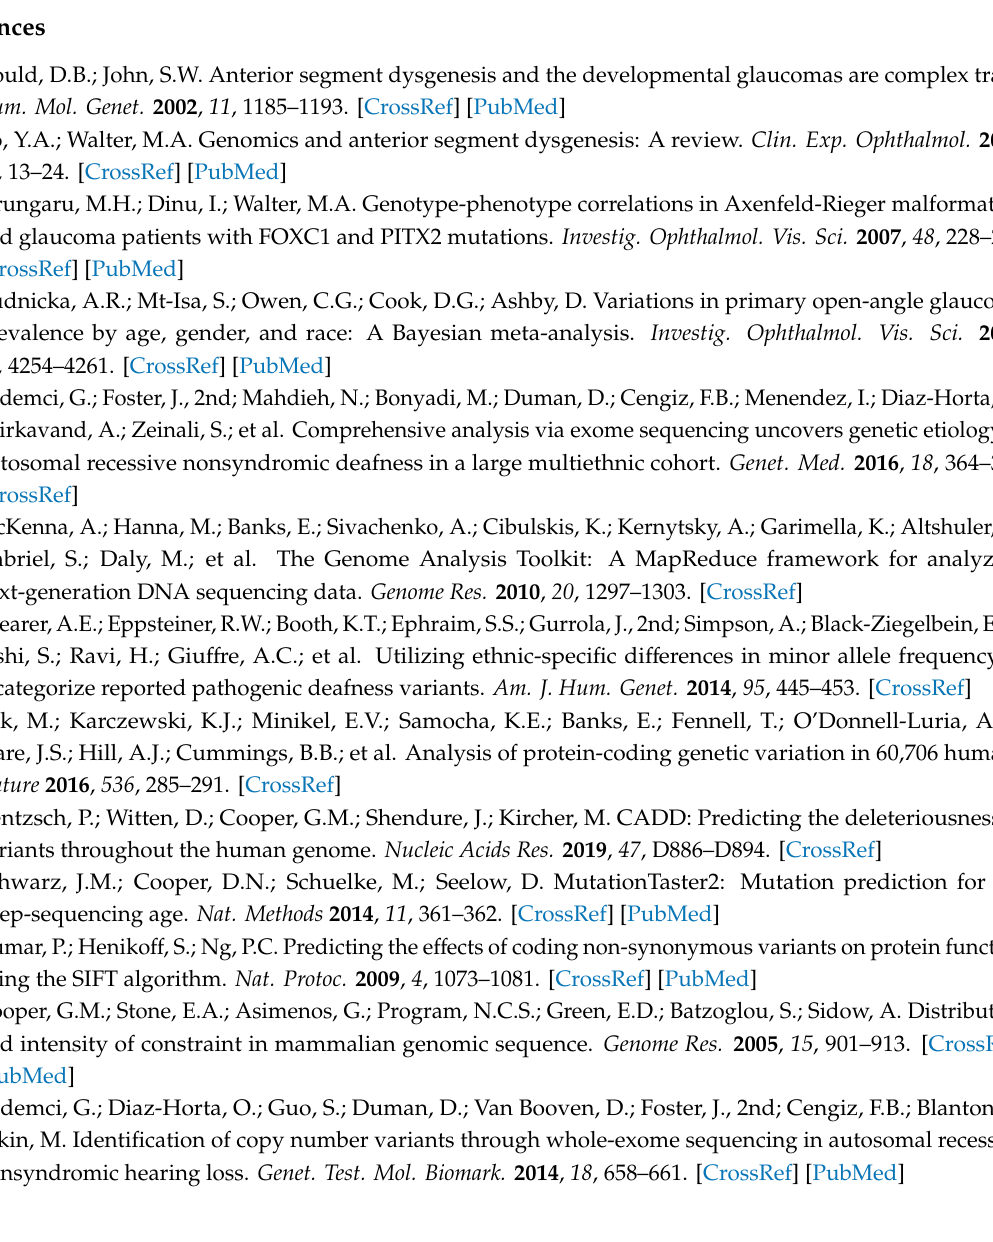
Table S1: List of the genes used for the filtering by using ES in our cohort. Table S2: Syndromic and isolated subjects in both solved and unsolved probands. Table S3: Phenotypic features of the unsolved probands. Table S4: Characteristics of common genes for anterior segment dysgenesis. Figure S1: Representation of the PAX6 gene deletion by using